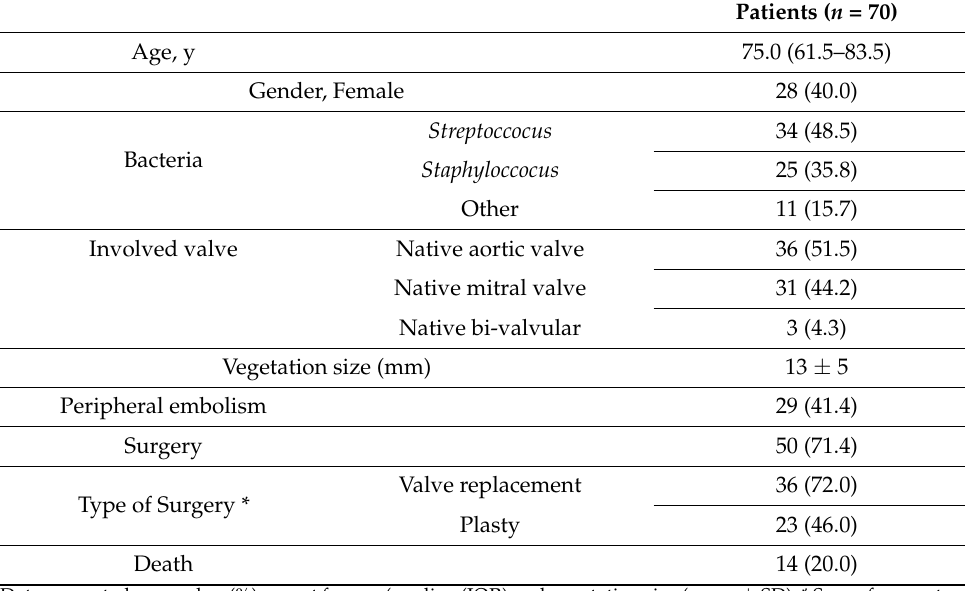
Table 1. Population characteristics of patients with infective endocarditis ( n =